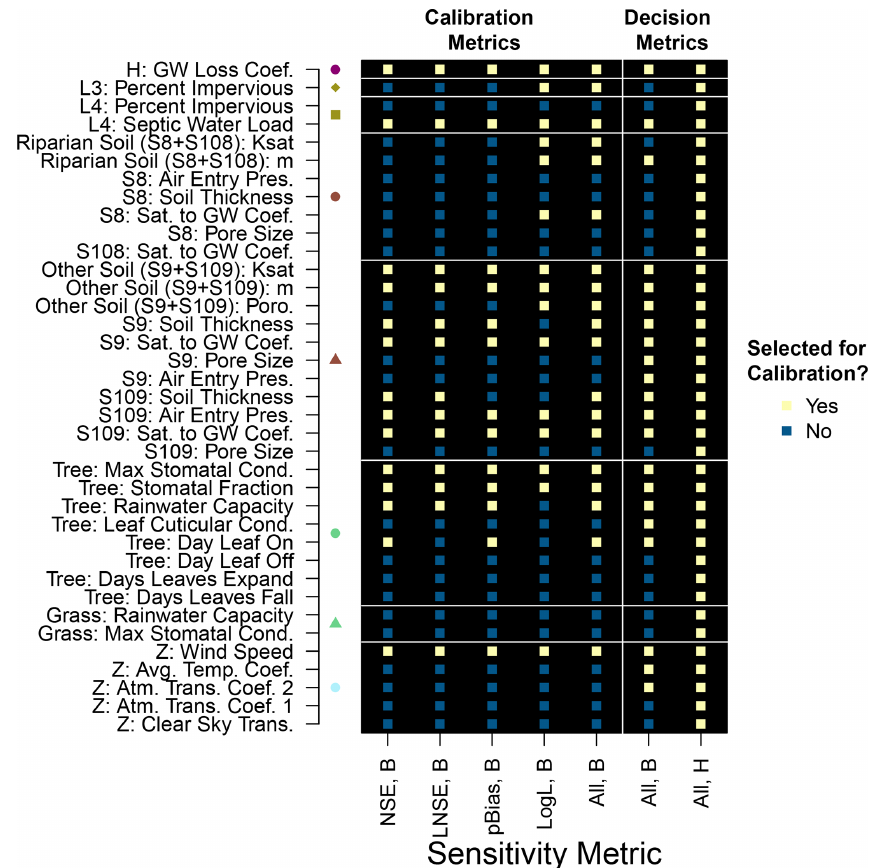
Figure 7. Indicators for whether or not a parameter would be selected for calibration for each of the calibration-relevant sensitivity metrics, and separately aggregated over all calibration-relevant and decision-relevant sensitivity metrics. B and H in the x -axis labels indicate basin outlet or hillslope outlet. Vertical white lines divide the calibration and decision-relevant sensitivity metric results. Other styles match Fig.